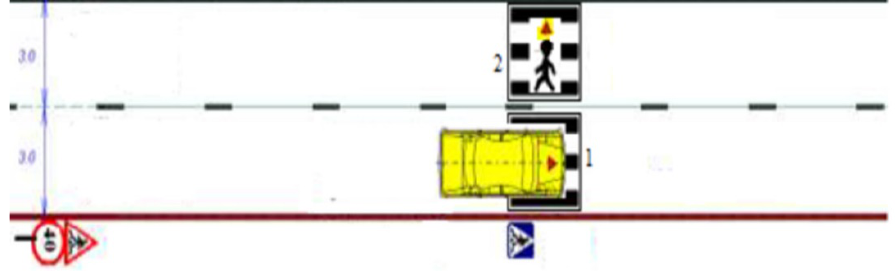
Fig. 11. The scheme of the location of the pedestrian and the car at the moment at the unregulated pedestrian crossing at the